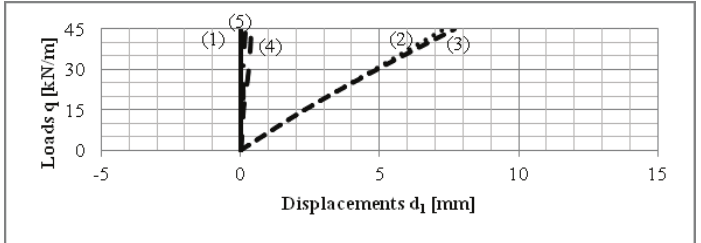
Fig. 6a. Displacements d 1 (mm) depending on the use of sheet piles as a cover of the foundation. Horizontal load applied at the bearing points